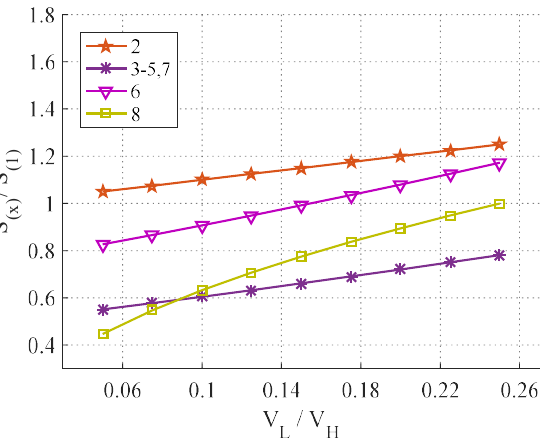
Figure 8. Total energy stored in capacitors (converters 1–8 described in Table 1).